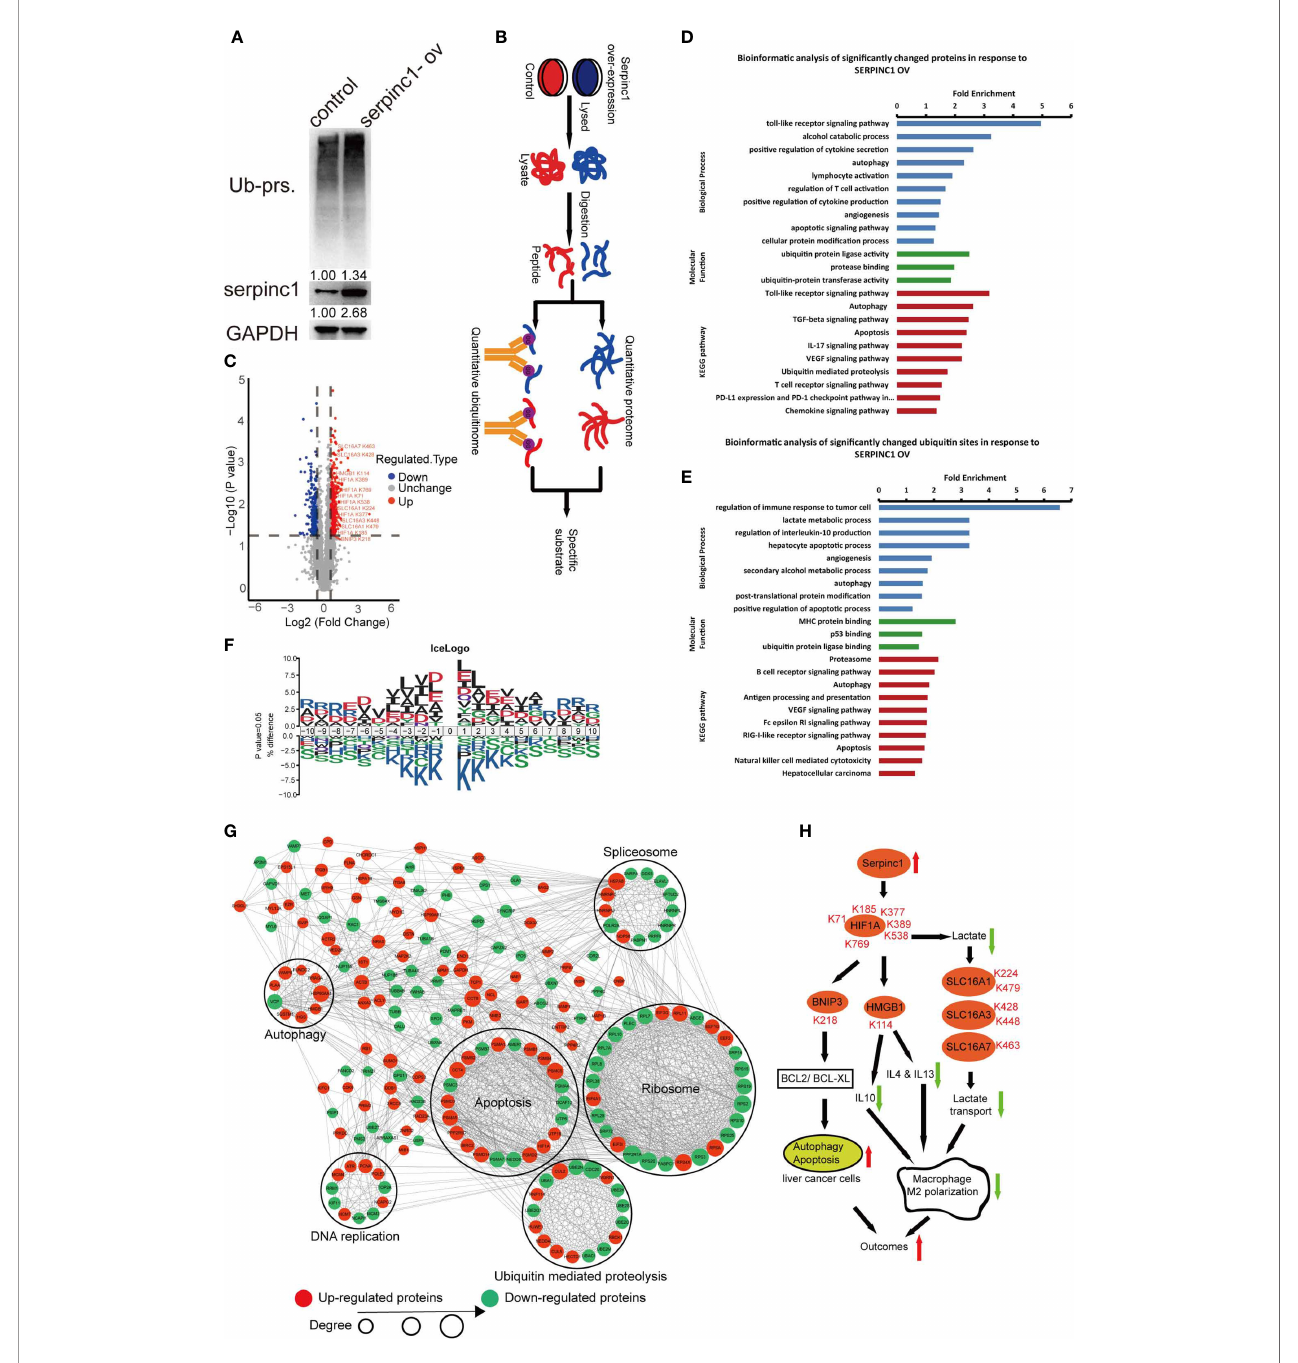
FIGURE 6 | Serpinc1 overexpression orchestrated proteome and ubiquitinome in HepG2 cells. (A) Detection of ubiquitinated proteins, serpinc1 protein expression after overexpression of serpinc1 (serpinc1-ov) in hepatocellular carcinoma cell line HepG2 by western blot. (B) The diagram shows the experimental process of quantitative proteome and ubiquitinome of overexpression of serpinc1. (C) Volcano plot of ubiquitinated modi fi ed sites change in response to serpinc1 overexpression in HepG2 cells. (D) GO analysis and KEGG pathway of the signi fi cantly changed proteins identi fi ed in proteome. (E) GO analysis and KEGG pathway of the signi fi cantly changed ubiquitinated sites identi fi ed in ubiquitinome. (F) Motif enrichment of all ubiquitinated sites identi fi ed in ubiquitinome. (G) Protein-protein interaction of signi fi cantly changed ubiquitinated sites identi fi ed in ubiquitinome. (H) Scheme of serpinc1 regulated the apoptosis of liver cancer cells and macrophage M2